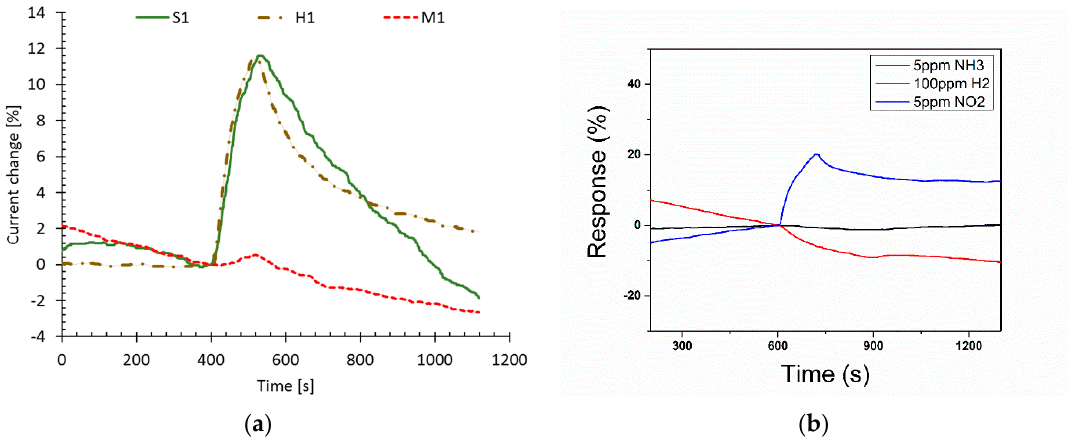
Figure 9. ( a ) Gas response plots to 5 ppm of NO 2 for the three types of devices as shown in Figure 8. Data labeled M1 corresponds to a device with no mesh. Data labeled H1 corresponds to a device with a dielectric core mesh. Data labeled S1 corresponds to a device with a dielectric core mesh and infiltrated SU-8 polymer. Data were normalized to the device response right before gas was turned on at 400 s. ( b ) Gas response plots to 5 ppm NH 3 , 5 ppm NO 2 , and 100 ppm H 2 of the S1 sample.